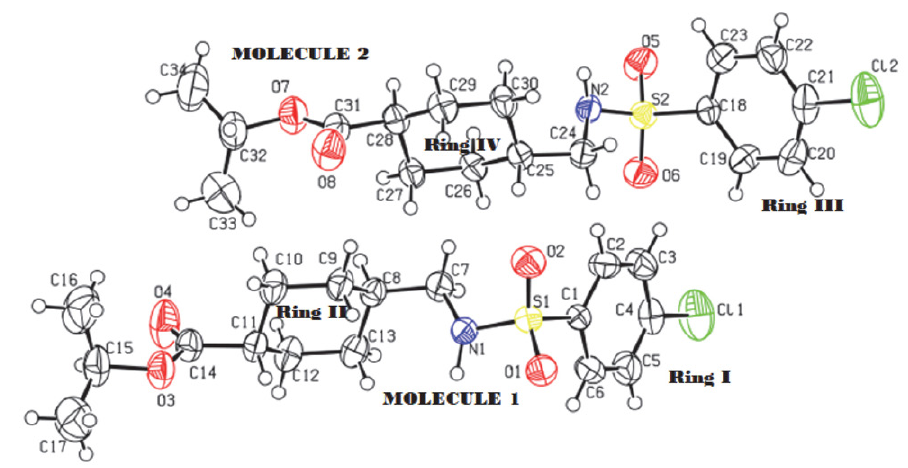
Figure 1. ORTEP diagram of 3 with thermal ellipsoids were drawn at 50% probability level